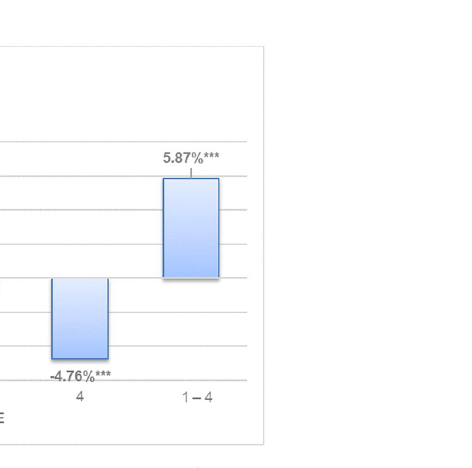
Fig 3. Size-adjusted abnormal returns. Long-term operating asset accruals.